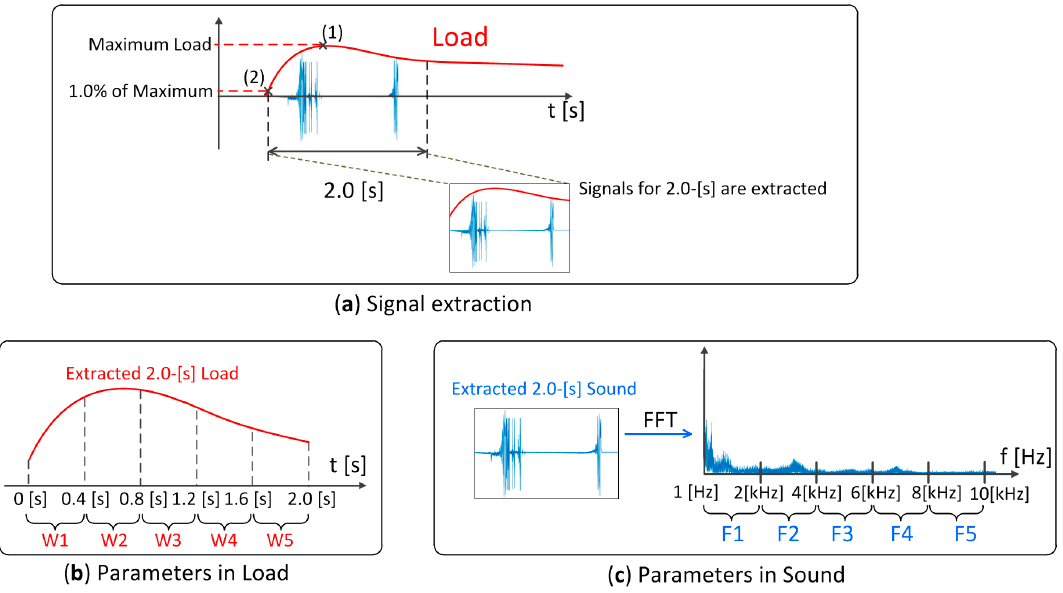
Figure 7. Signal Processing: ( a ) 2.0 s signal extraction; ( b ) parameters W1 – W5 and; ( c ) parameters F1 – F5.